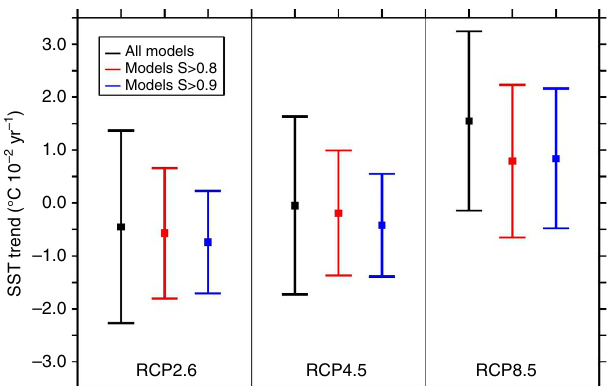
Figure 7 | Reduction of model uncertainty over the SPG. Model ensemble mean and spread of the 21st century SST trend ( o C10 (cid:3) 2 year (cid:3) 1 ) over the SPG in the RCP scenarios for different subsets of models: (black) all the 40 CMIP5 models; ( red ) CMIP5 models possessing a skill score S 4 0.8; (blue) CMIP5 models possessing a skill score S 4 0.9. Error bars indicate the standard deviation of the SST trend ensemble mean for the different subsets of models. Table 2 | Implications of models’ evaluation. Subset of models